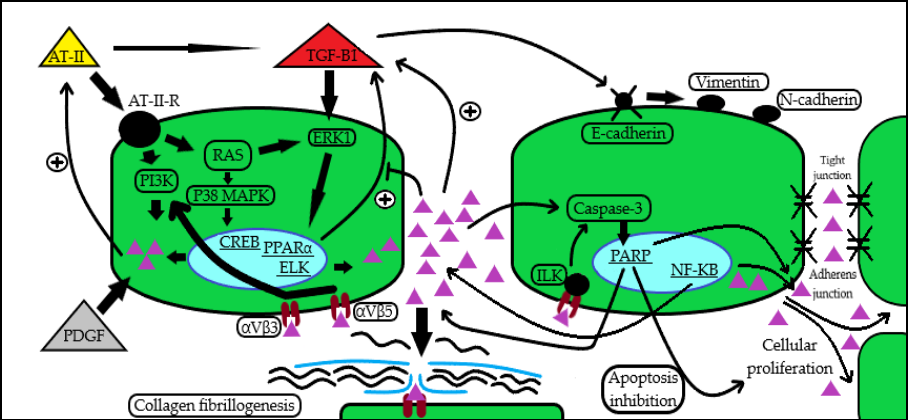
Figure 1. Periostin induction and action pathways in kidney disease. Periostin seems to be induced by a series of cytokines and growth factors (AT-II [19,20], TGF- β 1 [23,24], NF- κ B [27], PDGF [28,29]), subsequently leading to the activation of signaling pathways [19,20,23,25,27–29] that mediate ECM assembly through collagen fibrillogenesis [29,30], promotion of pro-inflammatory and anti-apoptotic routes [25,26,31], epithelial–mesenchymal transition with cellular migration, and enhanced adhesion and proliferation [23,24,31,32]. In the figure, the periostin molecule is illustrated by the all-purple triangular shape. Abbreviations: AT-II: angiotensin II; AT-II-R: angiotensin II receptor; RAS: Rat sarcoma virus GTP-ase; TGF- β 1: transforming growth factor β 1; NF- κ B: nuclear factor kappa-light- chain-enhancer of activated B cells; PDGF: platelet-derived growth factor; ECM: extracellular